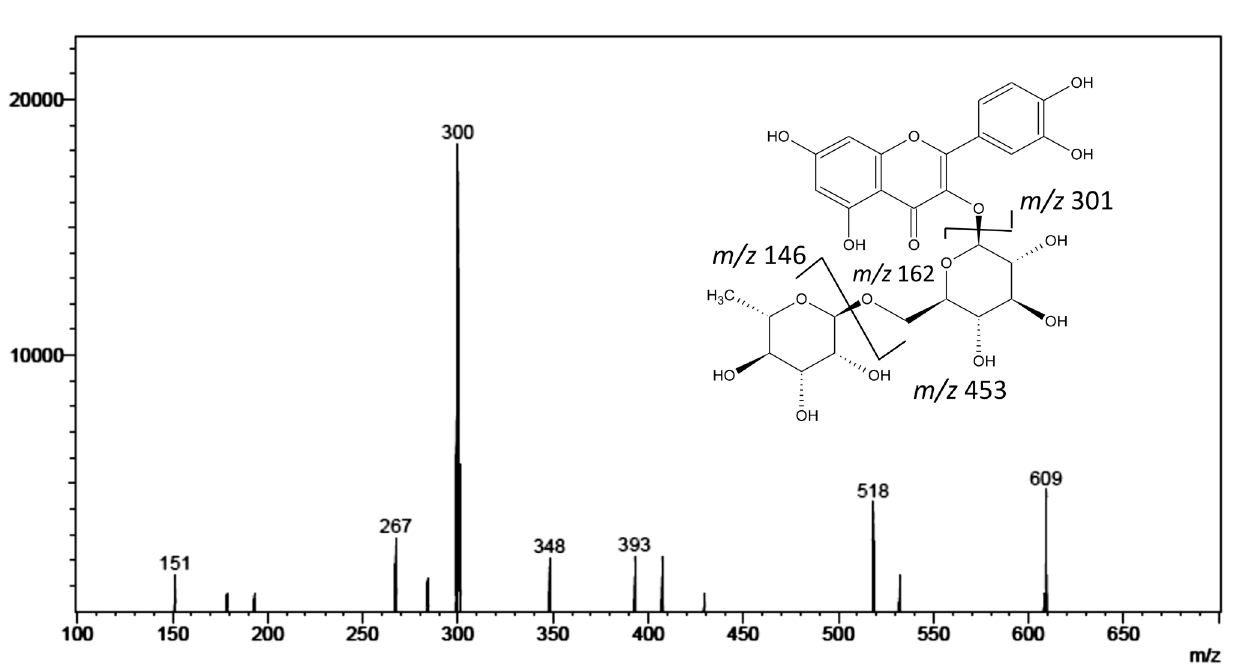
FIGURE 4 - The MS² spectrum of the precursor ion m/z 609 using 20eV of collision